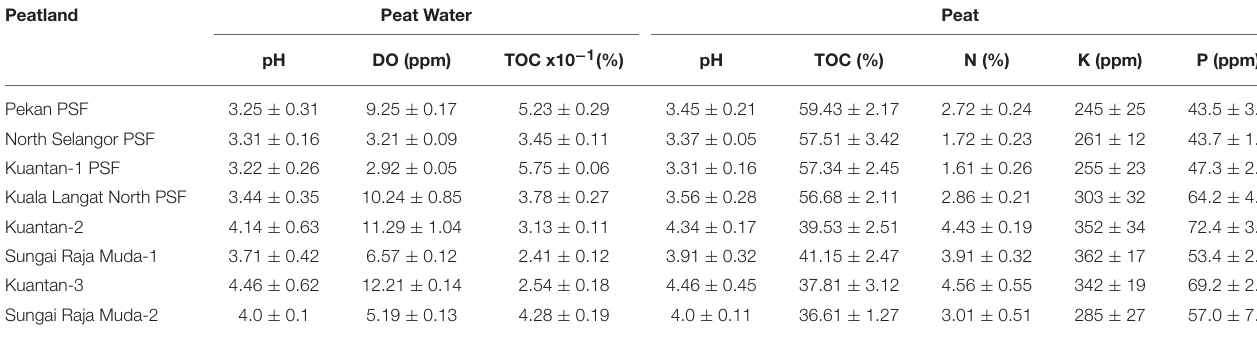
TABLE 3 | Chemical properties of peat water and surface peat at each site, ranked in order of increasing degradation level (mean values ± 1 S.D; n = 3). Peatland Peat Water Peat pH DO (ppm) TOC x10 − 1 (%) pH TOC (%) N (%) K